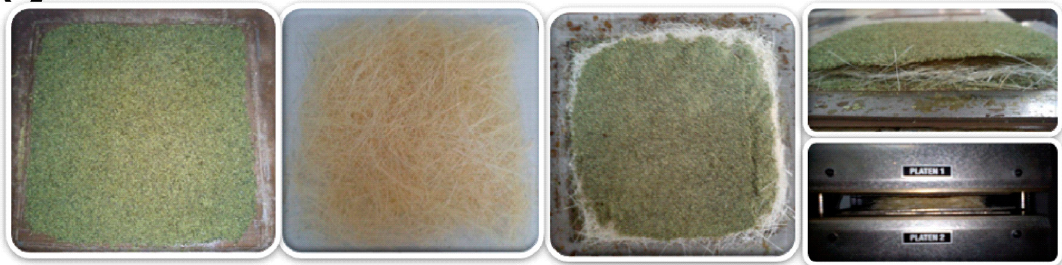
Figure 2. Biobased composite preparation: ( a ) Mopa-Mopa compacted sheet; ( b ) nonwoven fique mats; ( c ) Mopa-Mopa/nonwoven fique mats/Mopa-Mopa laminate; ( d ) molding the biobased composite.